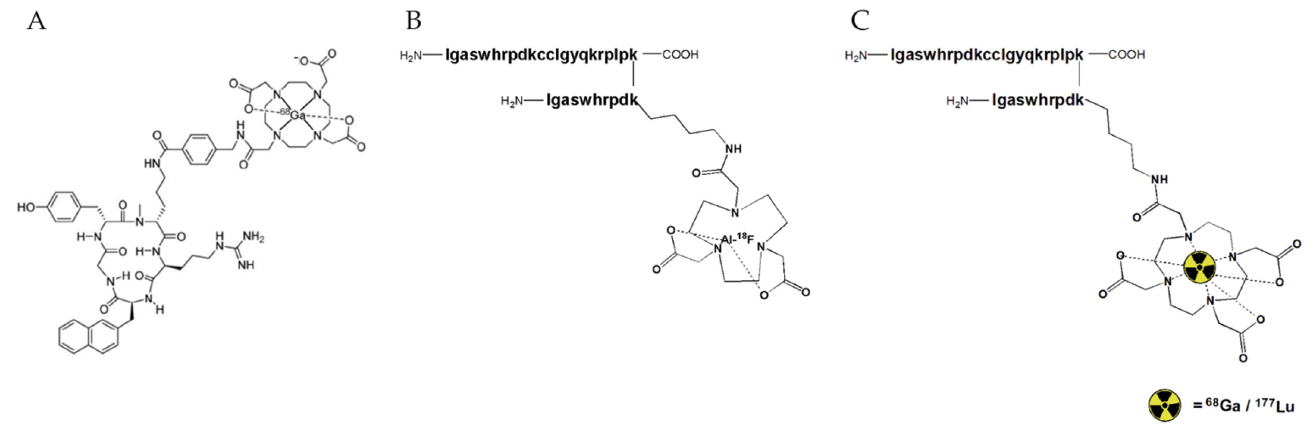
Figure 1. Chemical structures of radioprobes targeting the C-X-C chemokine receptor 4 (CXCR4). ( A ) [ 68 Ga]PentixaFor ( B ) [ 18 F]AlF-NOTA-DV1-k-(DV3) ( C ) [ 68 Ga]Ga-DOTA-DV1-k-(DV3) and [ 177 Lu]Lu-DOTA-DV1-k-(DV3).